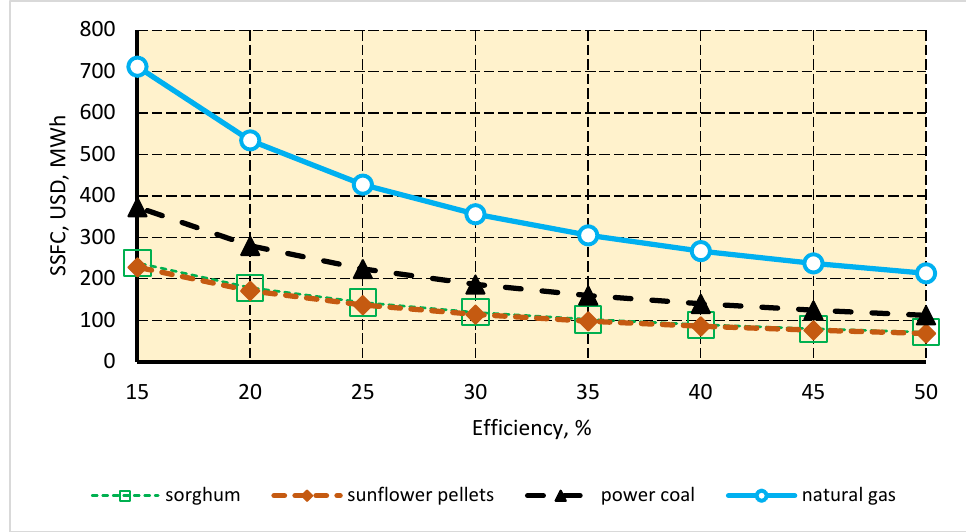
Figure 10. Specific fuel costs versus electric efficiency.